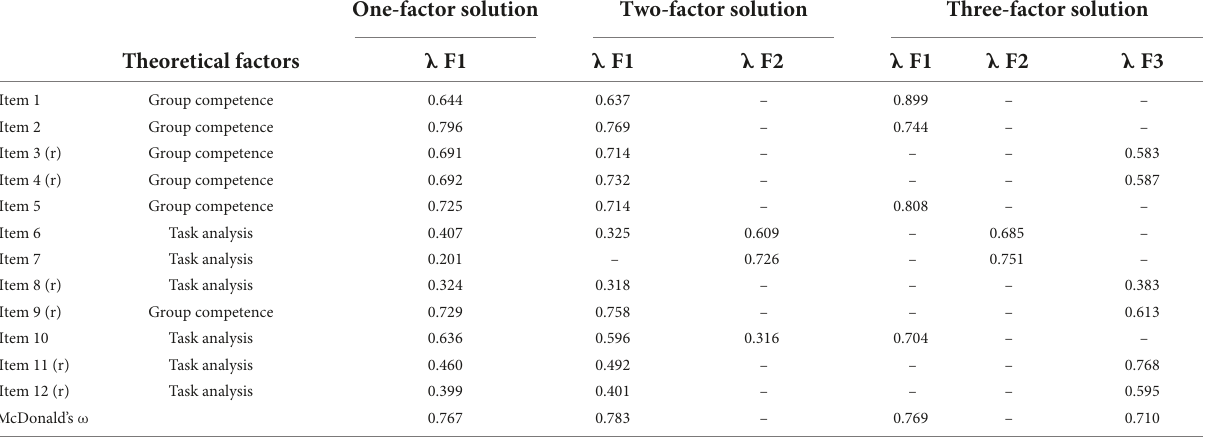
TABLE 2 Factor loadings of exploratory factor analysis with the one, two, and three factor solutions ( n = 693).